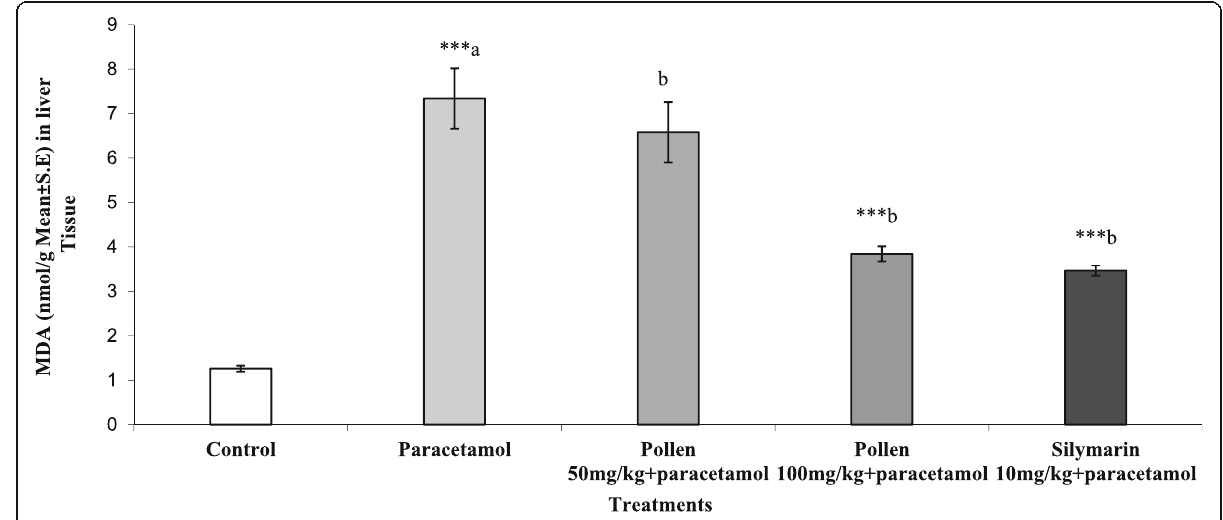
Fig. 1 Liver tissue malondialdehyde (MDA) levels. MDA levels in rats intoxicated with APAP alone and treatment with DPP and Silymarin. All values represent mean ± SEM. *** p < 0.001; ANOVA, followed by Dunnett ’ s multiple comparison test. a As compared with control group. b As compared with APAP